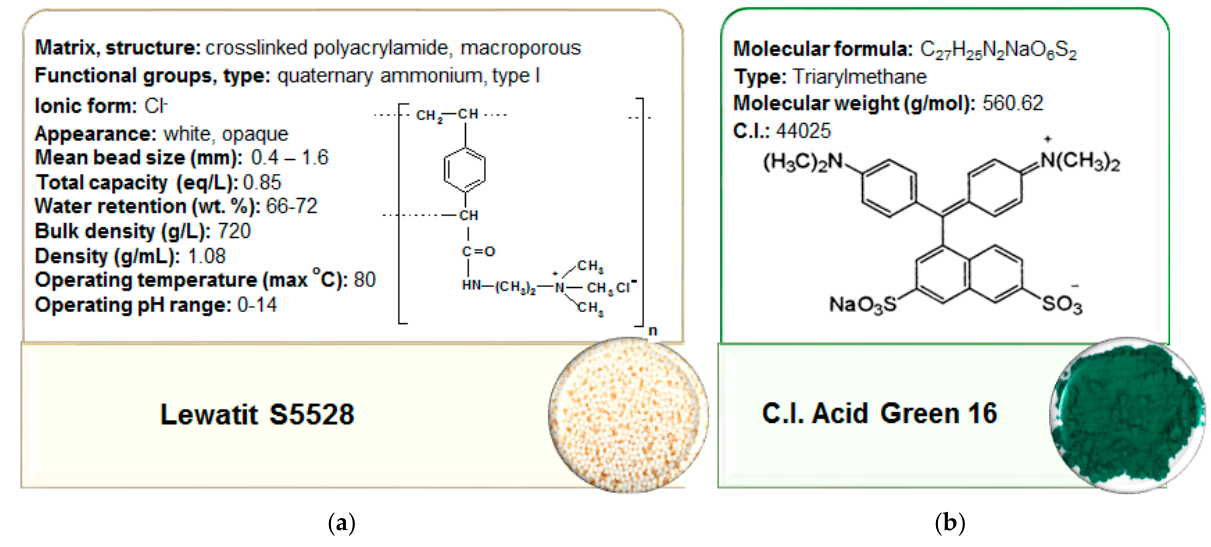
Figure 8. Properties of ( a ) applied anion exchange resin and ( b )